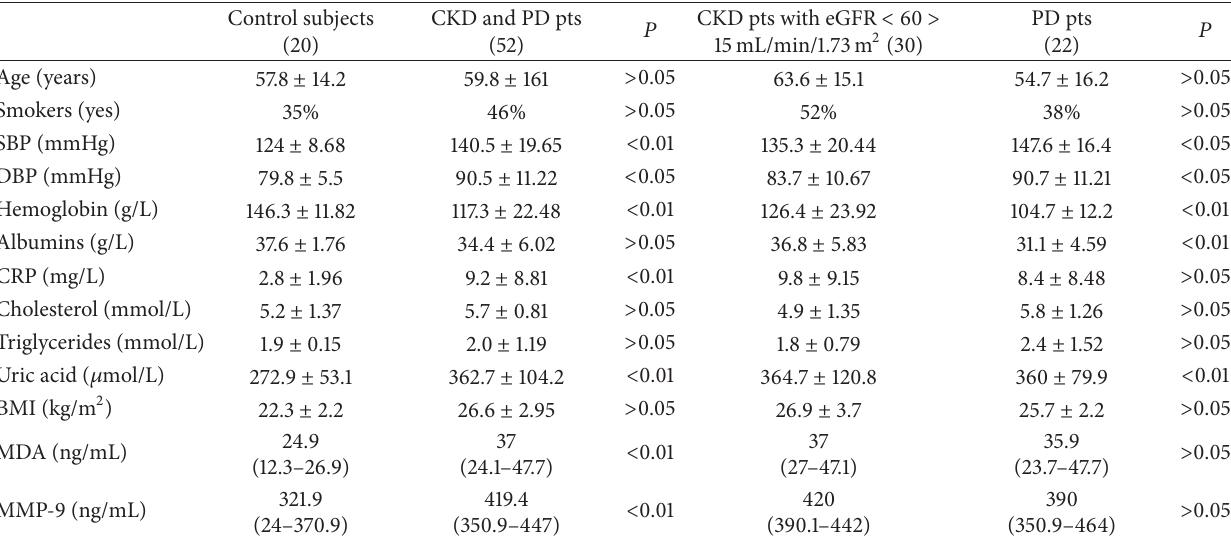
Table 1: Basal characteristics of monitored